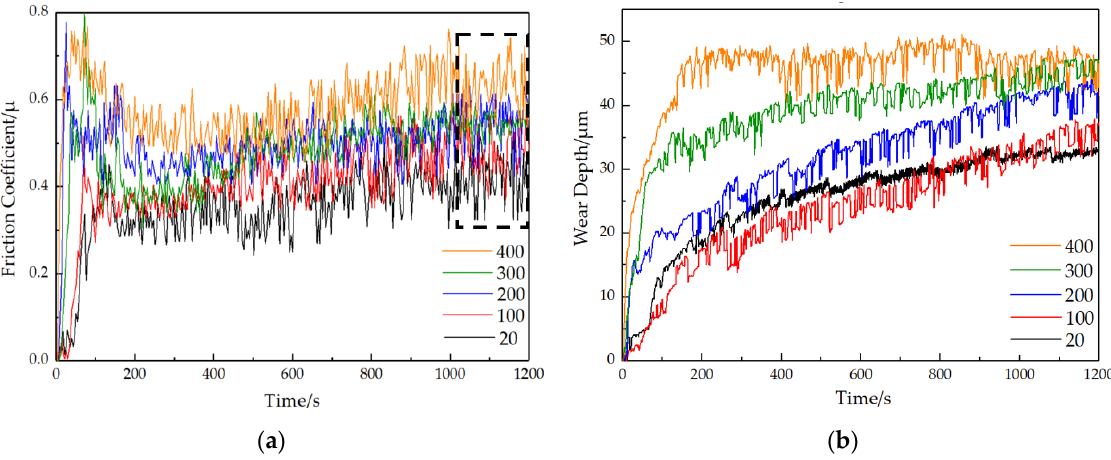
Figure 2. Friction coefficient and wear depth of stainless-steel wire at different temperatures vary with time in group 1: ( a ) friction coefficient; ( b ) wear depth. with time in group 1: ( a ) friction coefficient; ( b ) wear depth. Table 3. Friction coefficient and wear depth of 316L stainless steel in group 1.